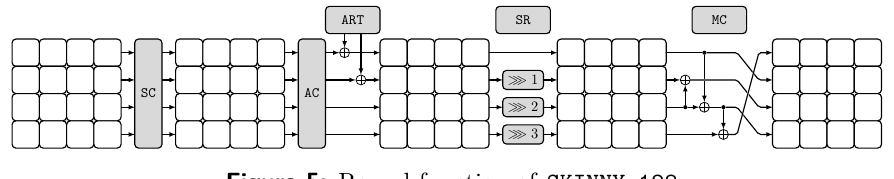
Figure 5: Round function of SKINNY-128